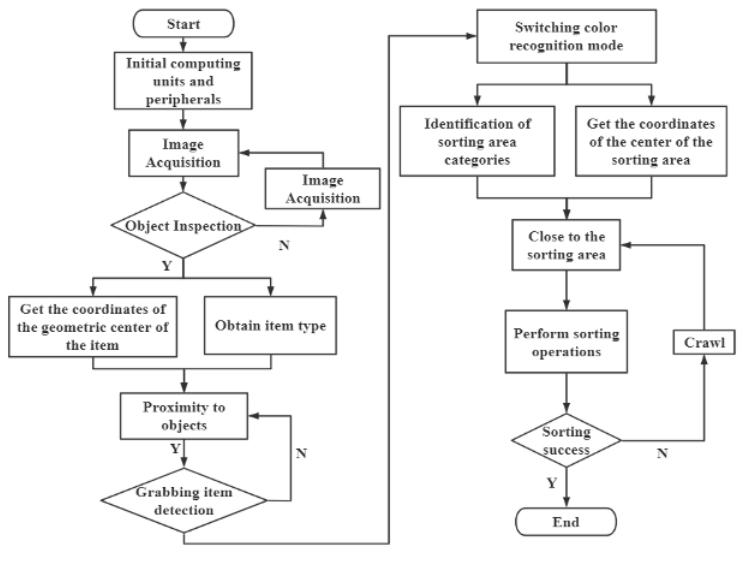
Fig. 3. System flow